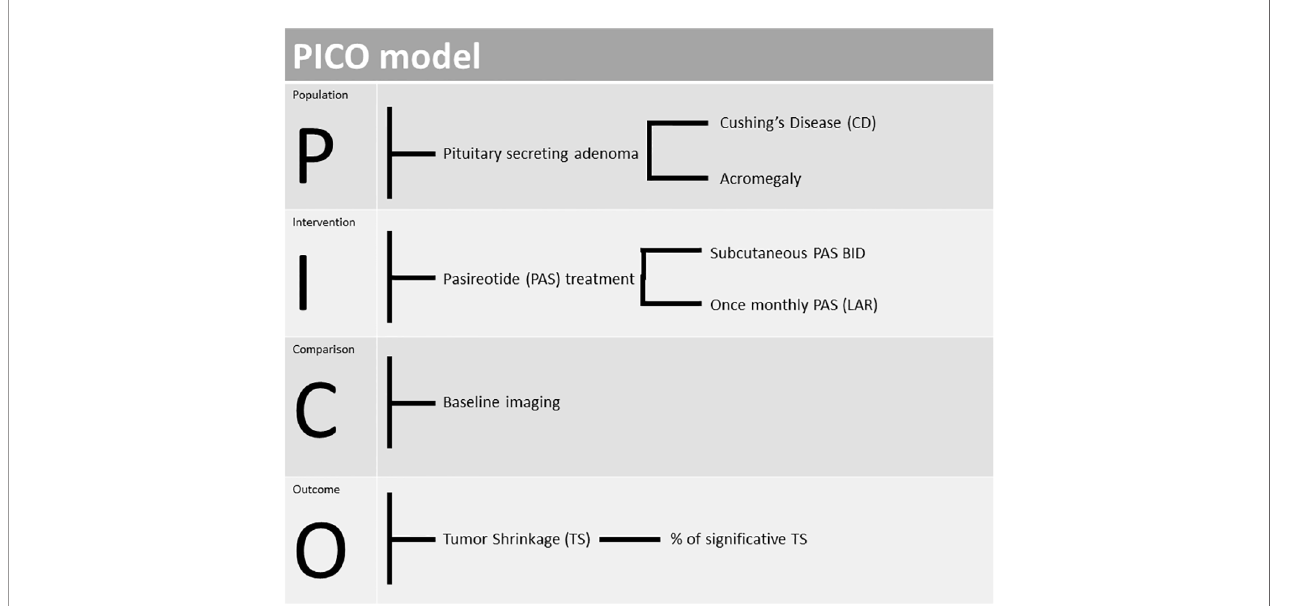
FIGURE 1 | PICO (Population-Intervention-Comparison-Outcome) model design to our